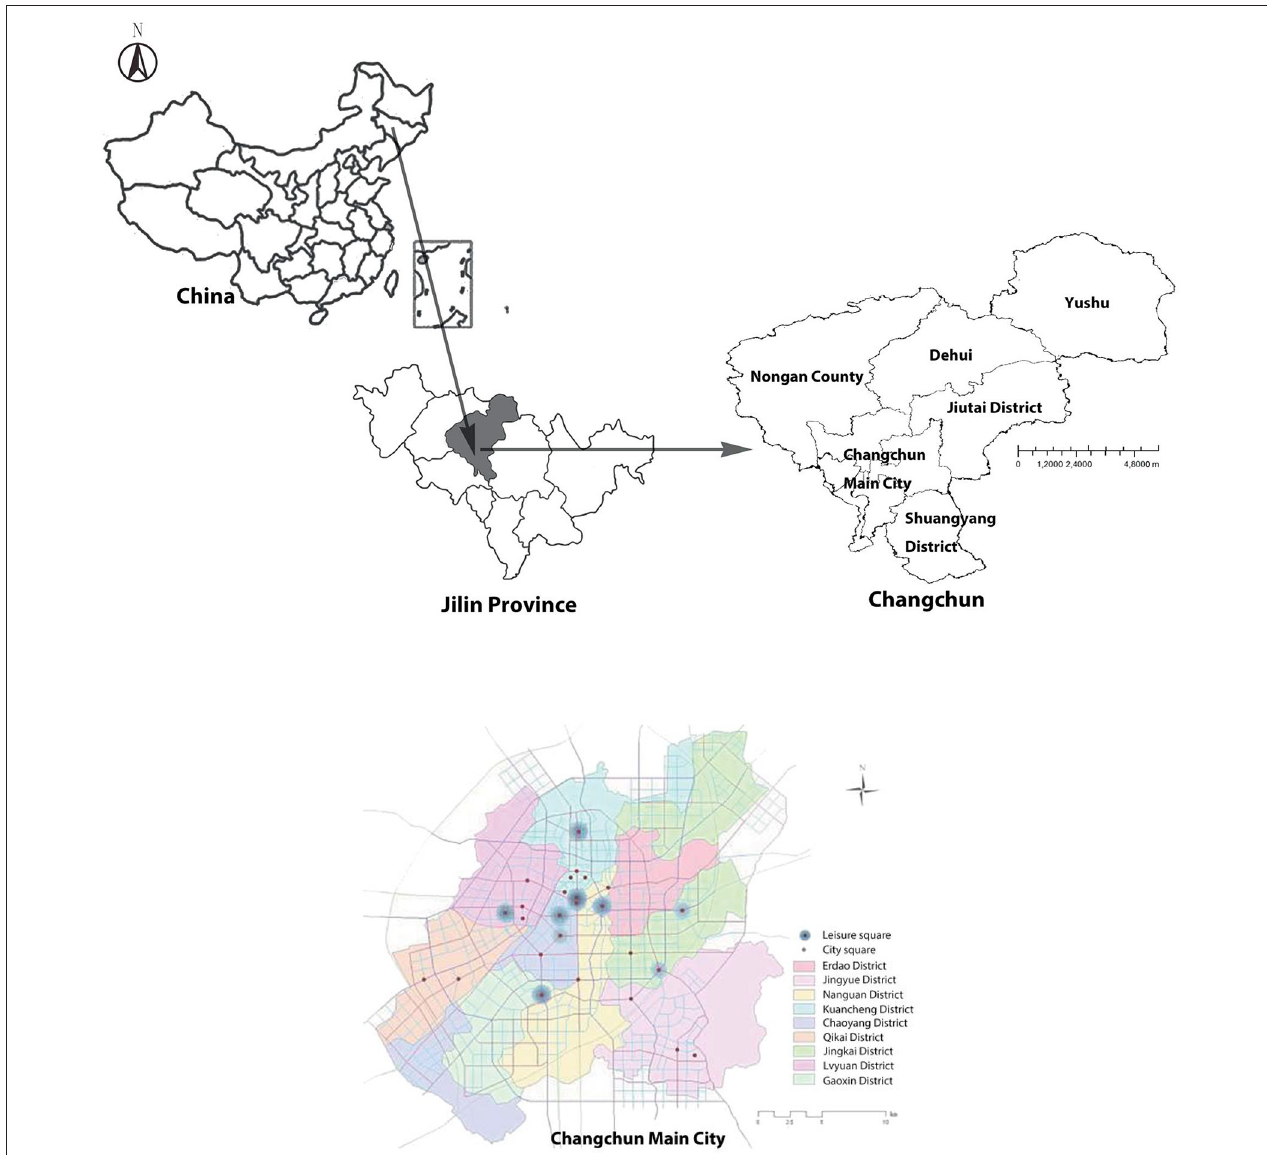
FIGURE 2 | Location of Changchun (Source: